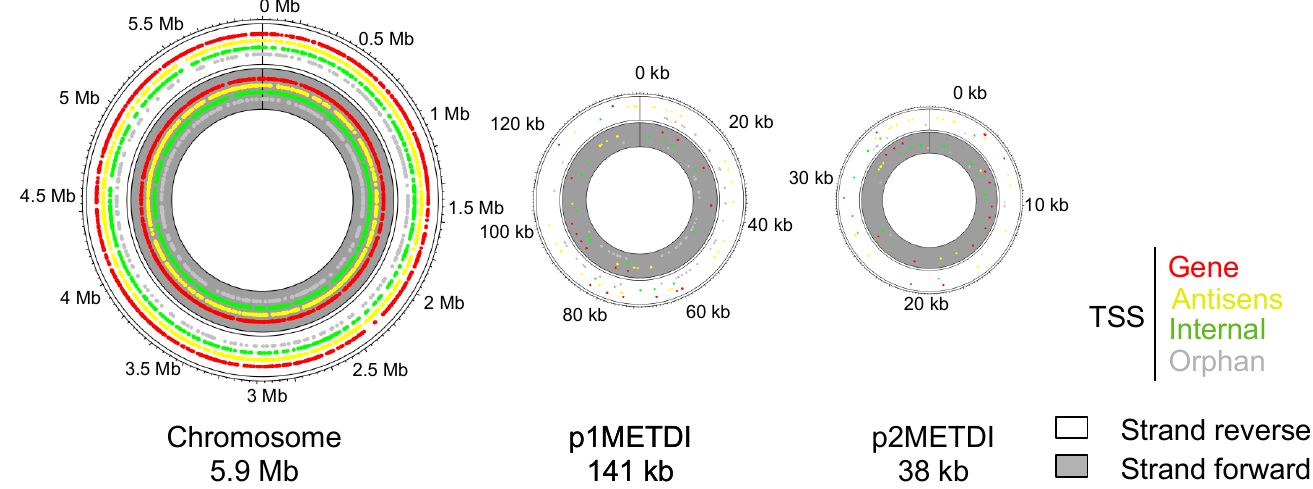
Figure 1. Distribution of the experimentally detected transcription start sites on the three replicons of M. extorquens DM4.